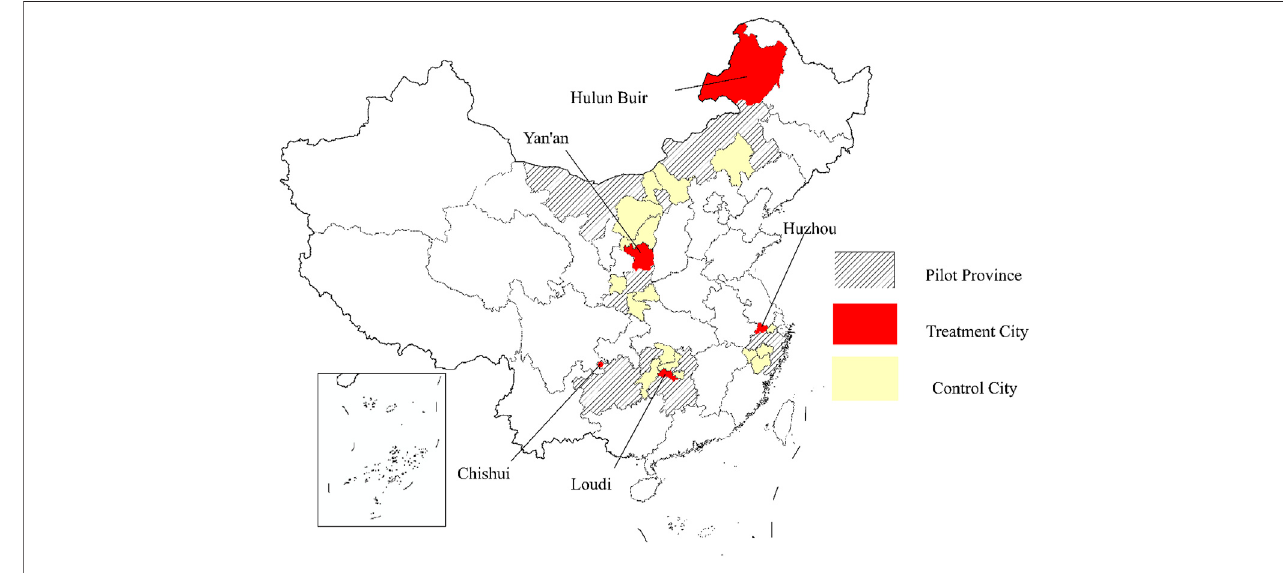
FIGURE 2 | Spatial distribution of NRC policy pilot areas in China.